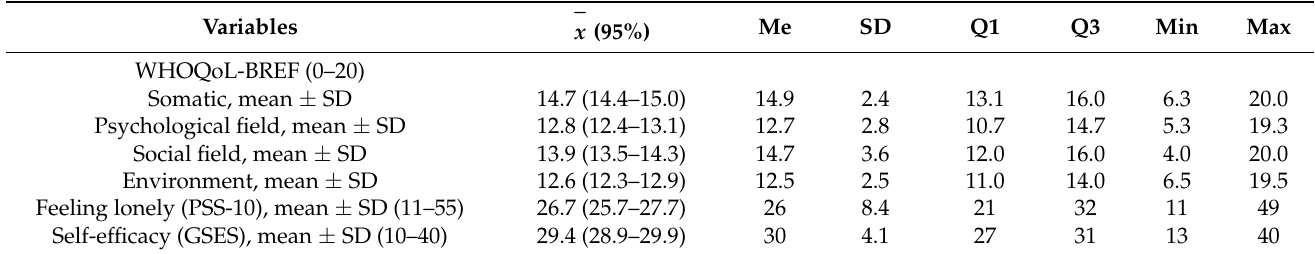
Table 2. Average scores of loneliness, quality of life, and generalized self-efficacy of subjects (n = 262).